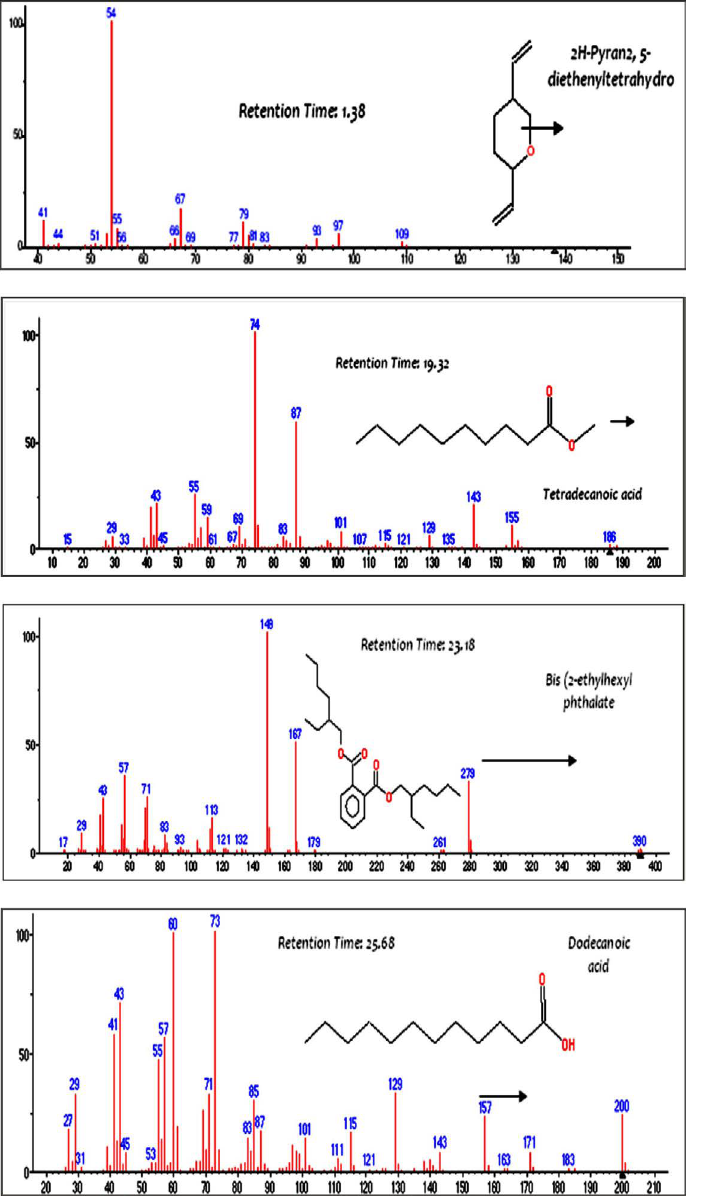
Fig. 5. Mass spectra of major constituents of the endotoxin produced by P. aeruginosa ATCC